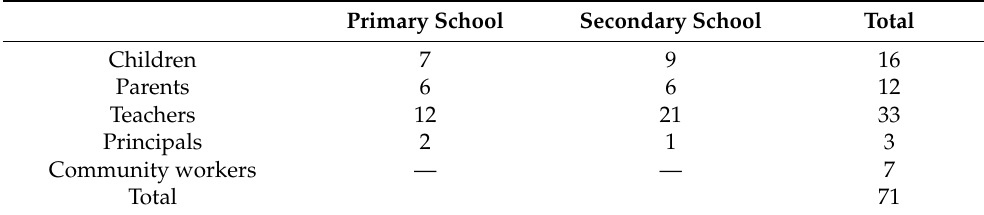
Table 1. Numbers of participant in each